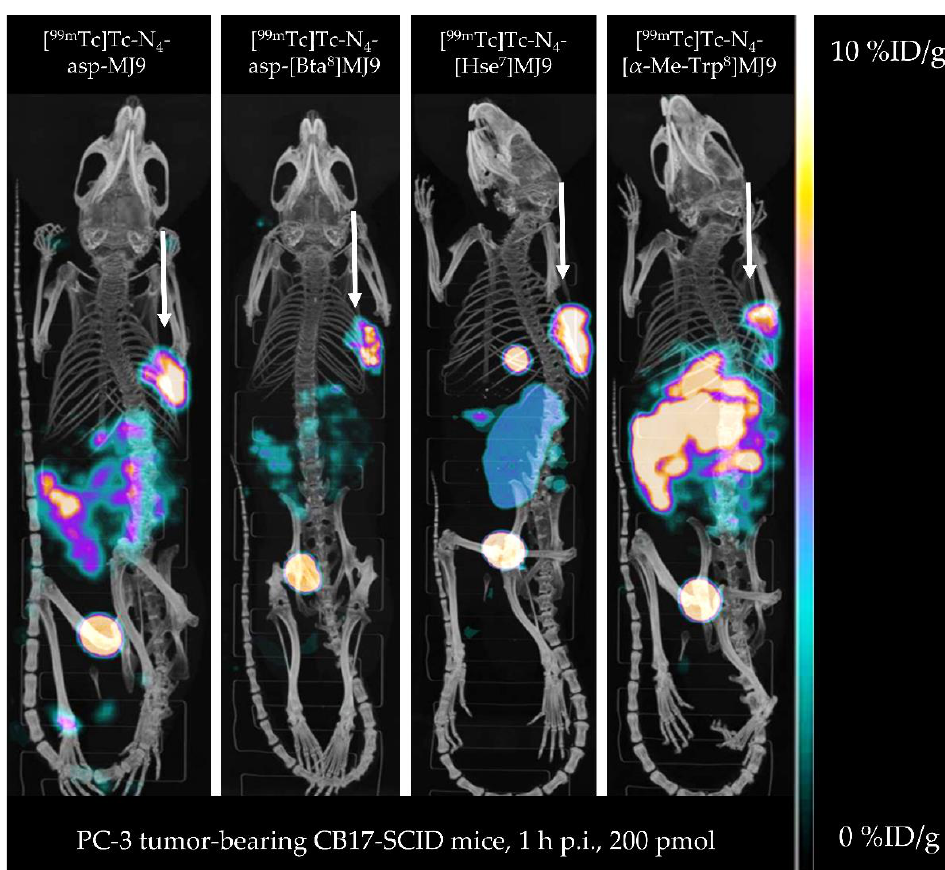
Figure 4. Maximum-intensity projection of PC-3 tumor-bearing CB17-SCID mice injected with [ 99m Tc]Tc-N 4 -asp-MJ9, [ 99m Tc]Tc-N 4 -asp-[Bta 8 ]MJ9, [ 99m Tc]Tc-N 4 -[Hse 7 ]MJ9 and [ 99m Tc]Tc-N 4 -[ α - Me-Trp 8 ]MJ9 (200 pmol each, n = 1). Images were acquired at 1 h p.i. PC-3 tumors are depicted by white